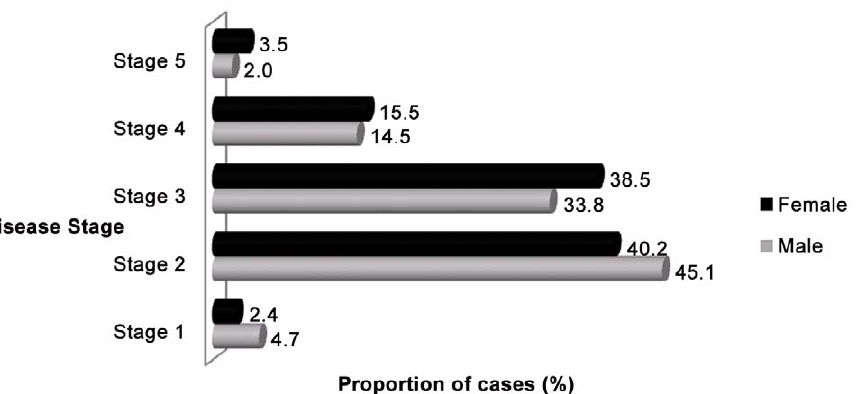
Figure 1. Clinical stages of podoconiosis among female and male patients in Debre Eliyas and Dembecha woredas , northern Ethiopia.